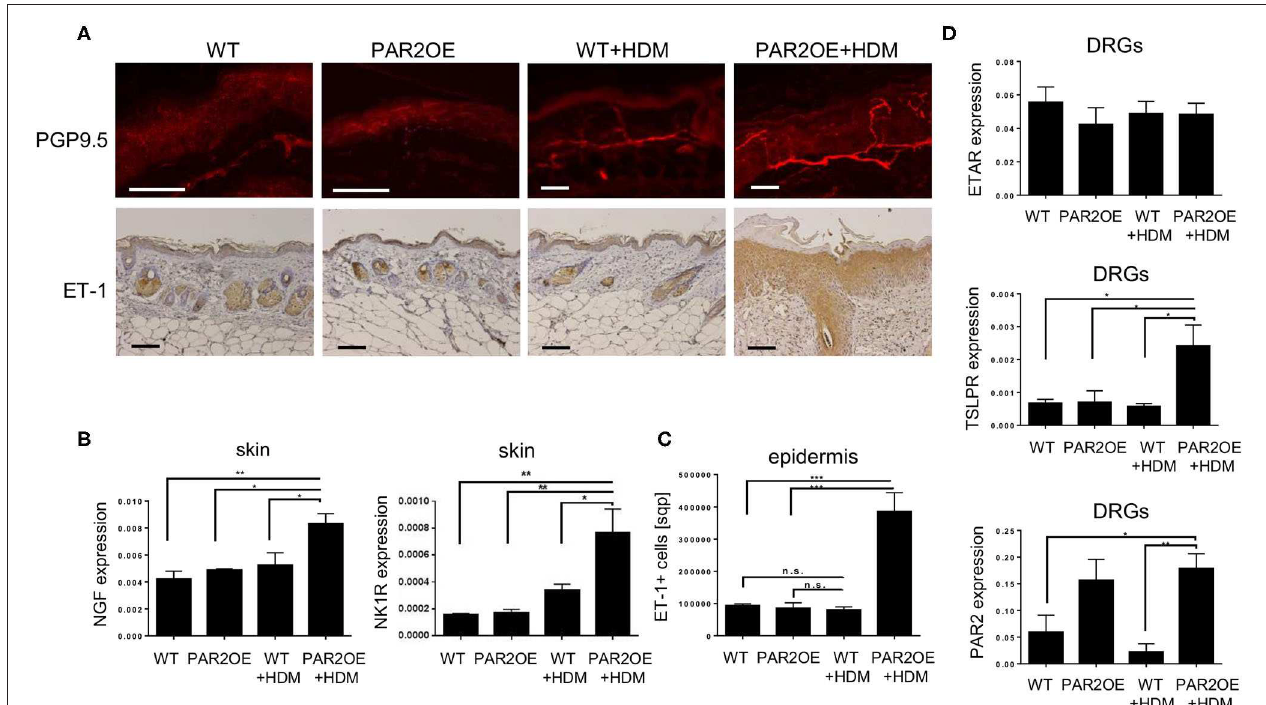
FIGURE 6 | Evidence for increased epidermo-neuronal communication, and Par2 upregulation on dorsal root ganglion neurons. All samples derive from 14-week-old PAR2OE and WT mice, treated with HDM or vehicle for the last 6 weeks. (A) Representative immunofluorescence of the ear (PGP9.5) and immunohistochemistry of the neck skin (ET-1) images of the skin. ET-1 staining is quantified in panel (C) . All bars represent 100 µ m. (B) Expression of NGF by qPCR in whole skin samples ( n = 4–5 mice per group). All graphs in this figure show mean ± SEM. * p < 0.05, ** p < 0.01, *** p < 0.001 (unpaired Student’s t- test). (C) Epidermal ET-1 staining by immunohistochemistry were automatically quantified in squarepixels (sqp) using ImageJ ( n = 4–5 mice per group, three slides per mouse). In addition, mean brown intensity is also increased in PAR2OE + HDM compared to PAR2OE ( p = 0.015, data not shown). (D) Expression of ETAR, TSLPR, and Par2 by qPCR on dorsal root ganglion (DRG)